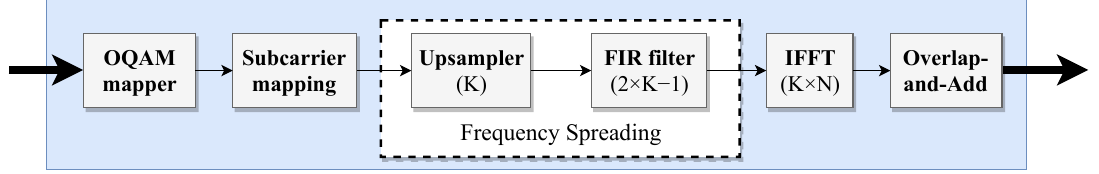
Figure 2. Datapath structure for frequency spreading Filter-Bank Multi-Carrier